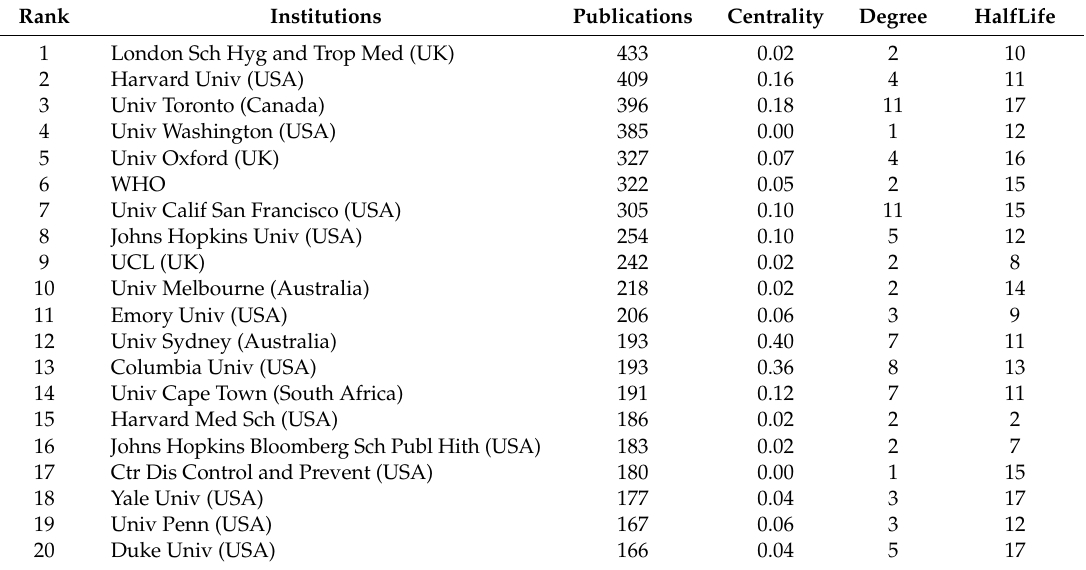
Table 3. The top 20 institutions.